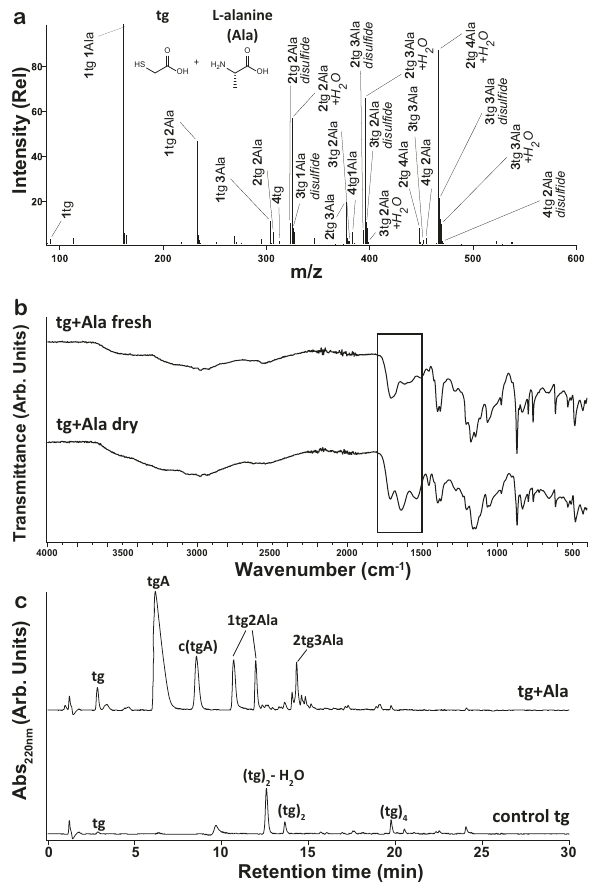
Fig. 2 Analytical data con fi rms the formation of thiodepsipeptides in dry- down reactions of tg and Ala. a Negative-ion mode ESI-MS spectrum of thioglycolic acid (tg) and alanine (Ala) after being dried at 65 °C for 7 days, indicating a variety of thiodepsipeptides. All labeled species correspond to [M-H] − ions. Species that are labeled with H 2 O correspond to species that have an additional H 2 O unit, which could be the result of non-covalent adducts. b Fourier transform infrared spectroscopy (FTIR) shows shifts in the C = O band and in the amide regions upon dry-down of tg and Ala, supportive of thiodepsipeptide formation. c HPLC chromatograms of products resulting from drying tg alone or tg with Ala at 65 °C for 7 days. Comparison between the two dry-down reaction products via hydrophobicity-based separation on a C18 column allows the identi fi cation of various oligomers that contain Ala. c(tgA) is the cyclic form of tgA, i.e.,